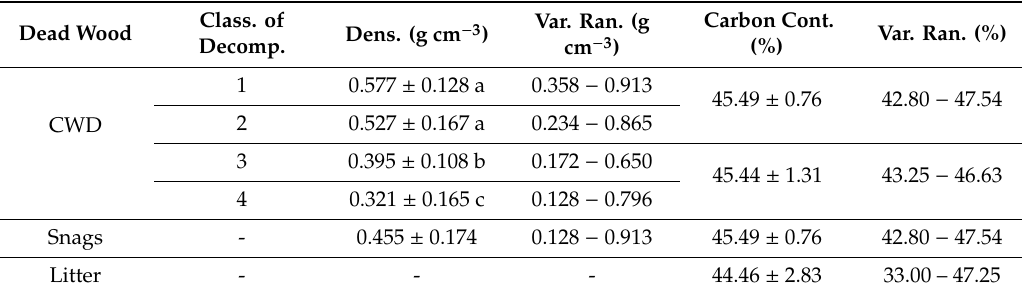
Means followed by the same letter do not differ at 5% by Tukey's test. Decomposition classes: (1) newly fallen to the soil with leaves and tree bark intact; (2) residues similar to those in class 1 but with tree bark showing rot or scaling; (3) residue at an advanced stage of decomposition with some resistance to being broken; (4) rotten and friable residues with no resistance when broken.